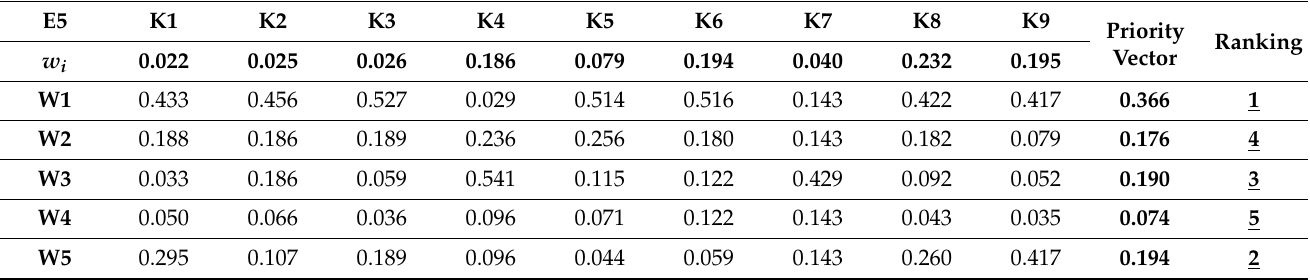
Table 7. Ranked list of the final weight distributions of the respective equipment variants according to Expert